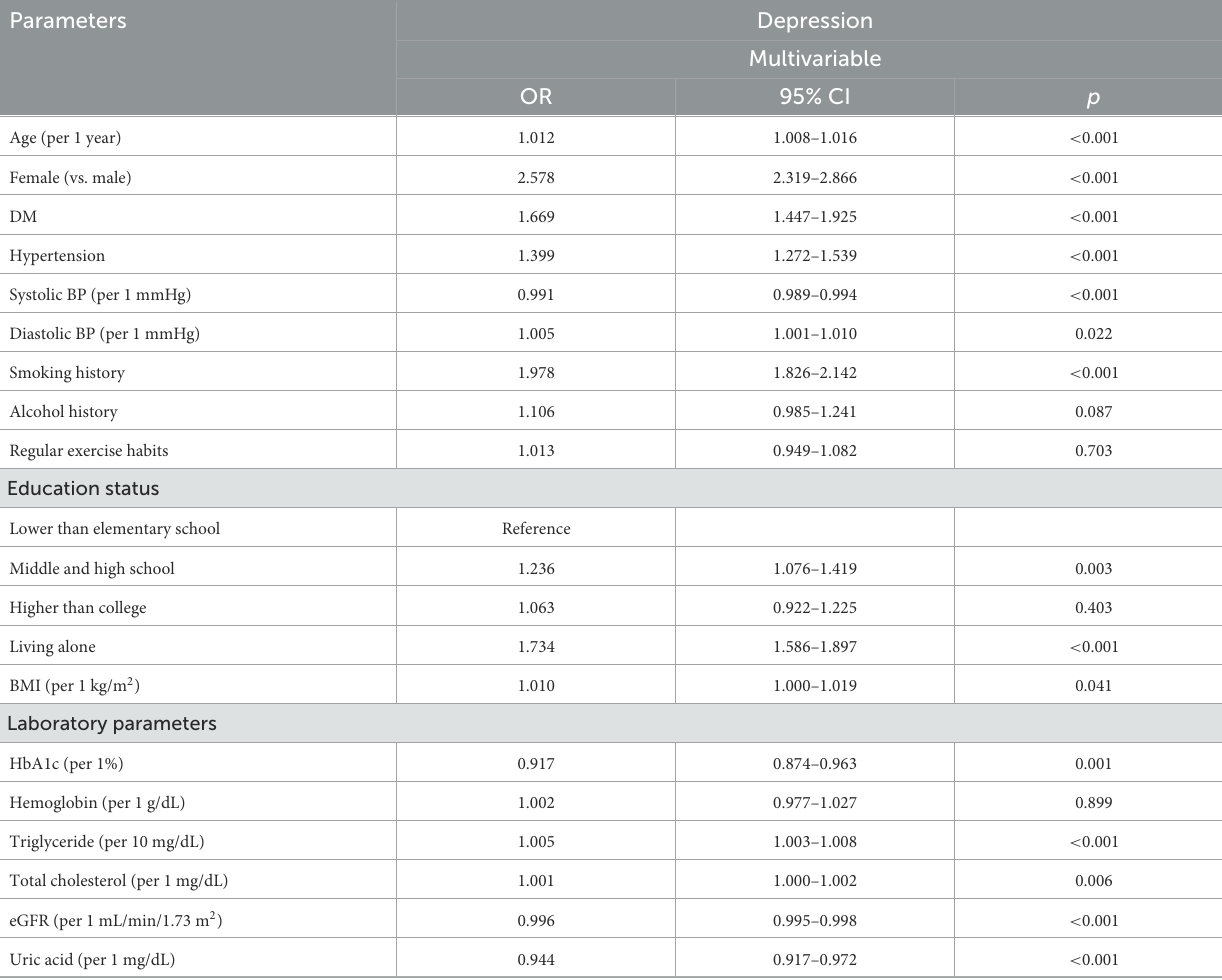
TABLE 2 Determinants for depression using multivariable logistic regression analysis in all study participants ( n = 121,601).